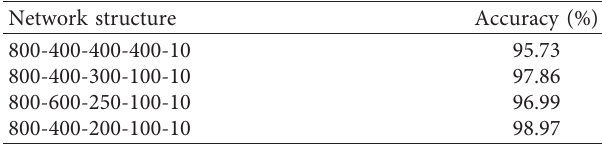
Table 2: Comparison of accuracy of different grid structures. Network structure